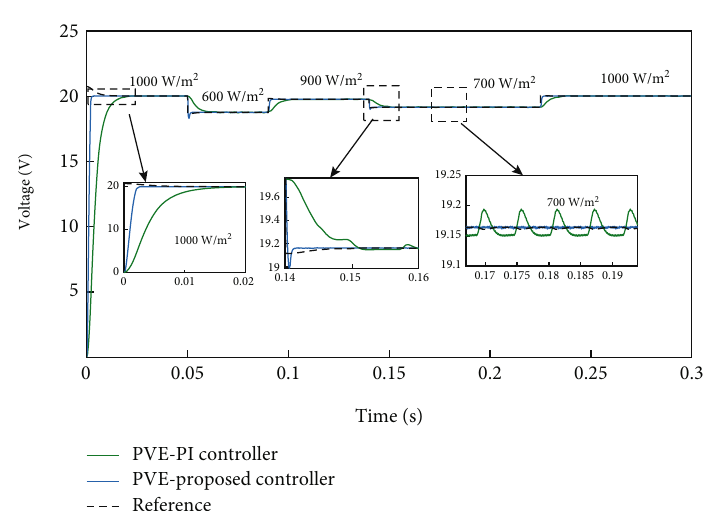
Figure 22: Dynamic performance comparison of the PVE-PI controller, with the proposed PVE nonlinear controller under changing irradiance.